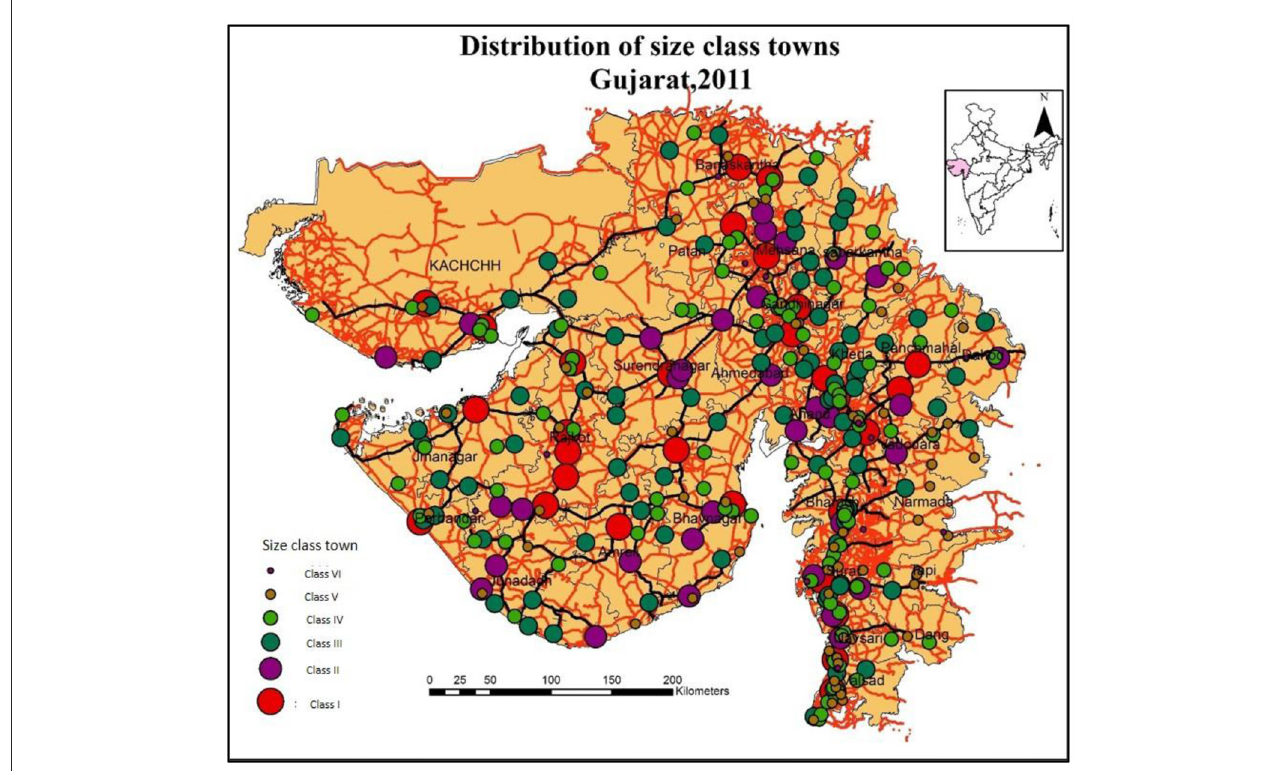
FIGURE5 Distribution of size class towns in Gujarat- 2011. Source: Prepared by the Authors, 2018.